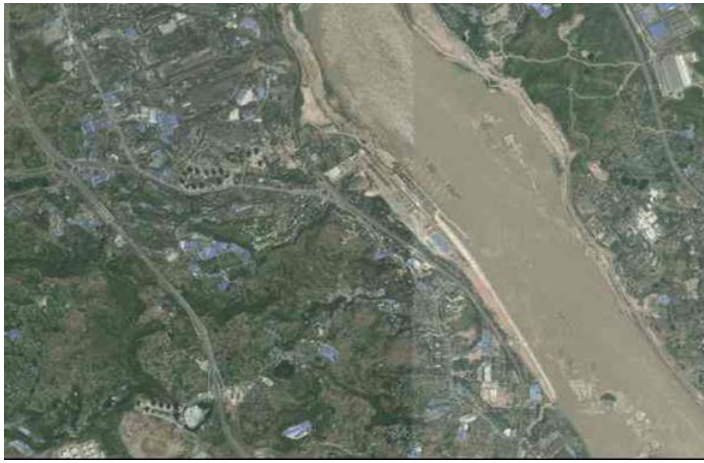
Figure 2. Satellite map of Jiansheng town [68].